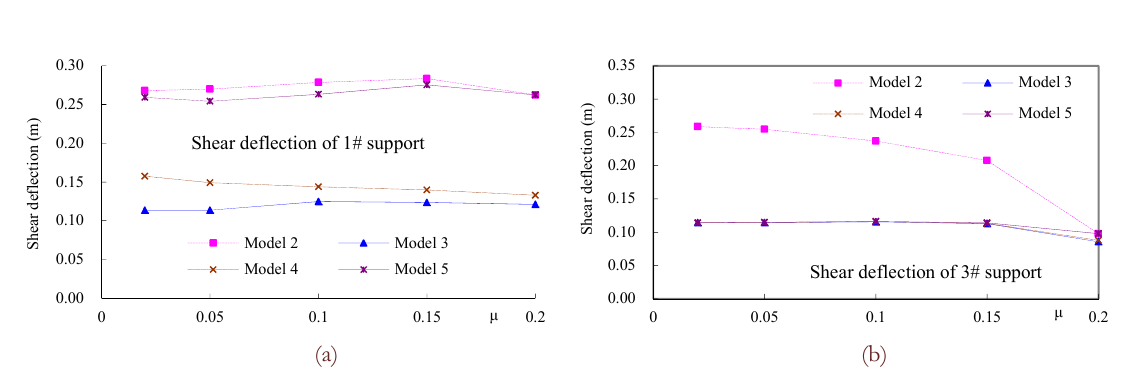
Figure 10: Shear deflection of movable supports under Tianjin